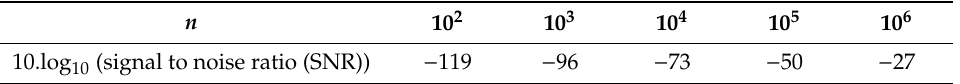
Table 1. Enhancement of the SNR with the number of imaging segments. n 10 2 10 3 10 4 10 5 10 6 10.log 10 (signal to noise ratio (SNR)) − 119 − 96 − 73 − 50 −